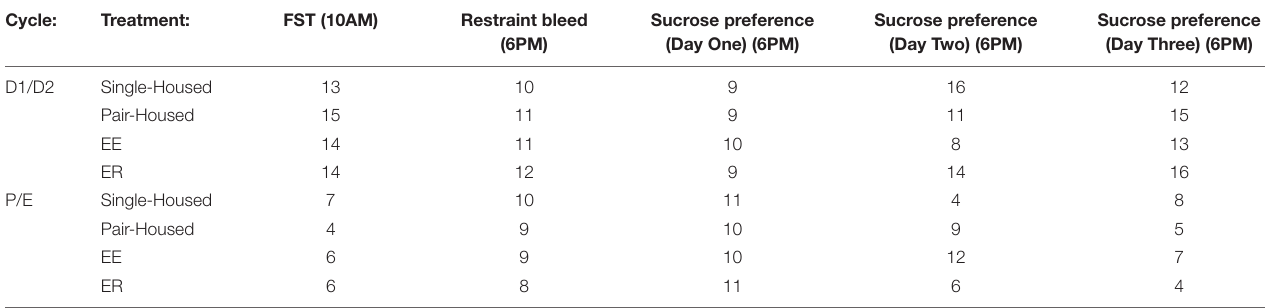
TABLE 2 | Number of animals in either D1/D2 or P/E across experimental groups.